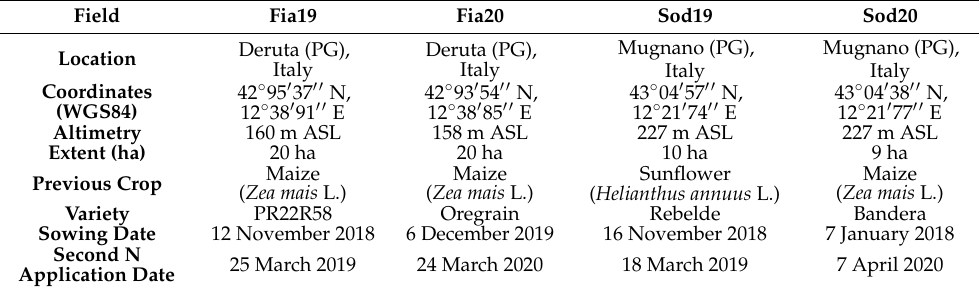
Table 2. Wheat varieties used for the experimentation and their main characteristics, as provided by the seed companies.